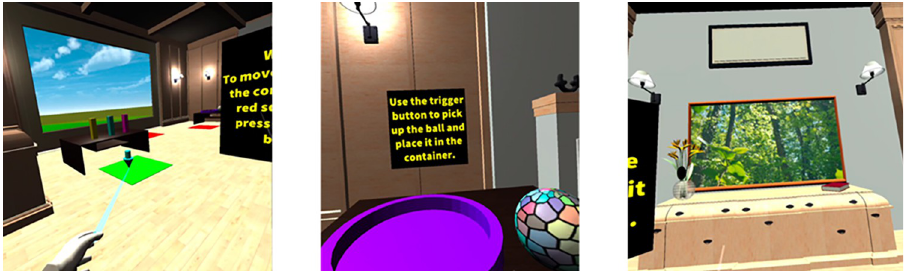
Fig 1. Images of the VR FOUNDations Training